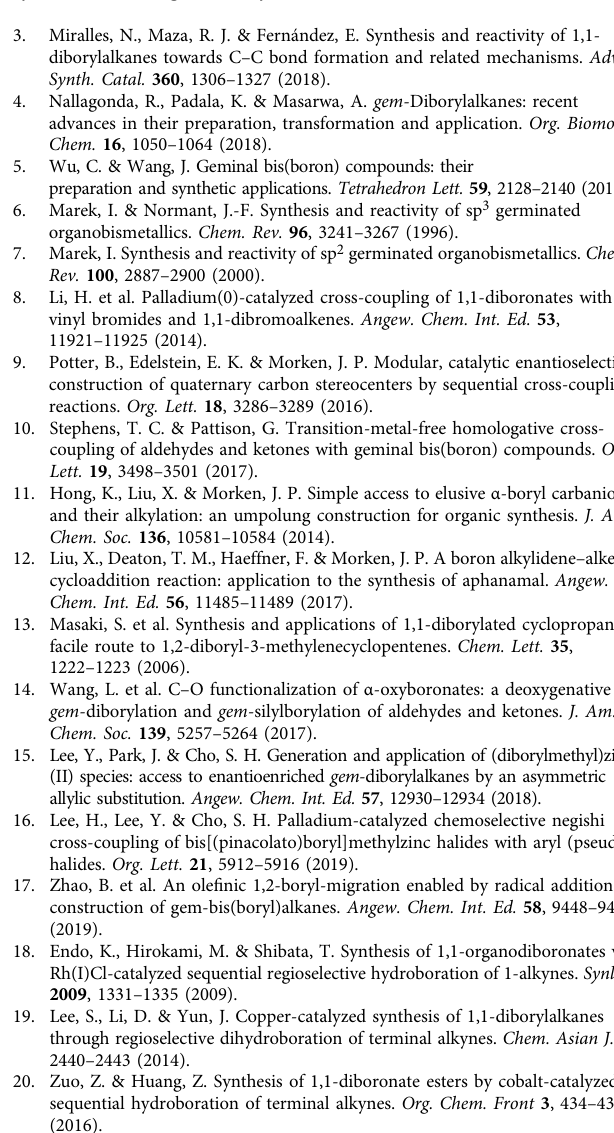
Fig. 8 Proposed mechanism. The proposed catalytic cycle for this cobalt-catalyzed chain-walking double